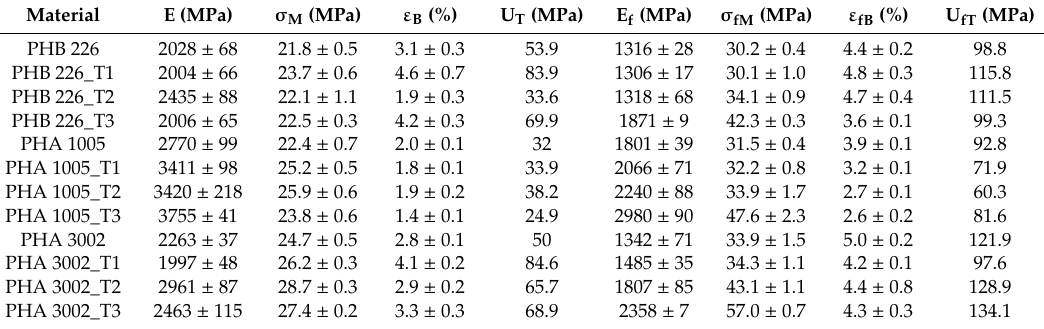
Table 2. Mechanical properties under tensile and flexural forces: modulus (E), flexural strength ( σ M ), elongation at break ( ε B ) and toughness (U) for all characterised